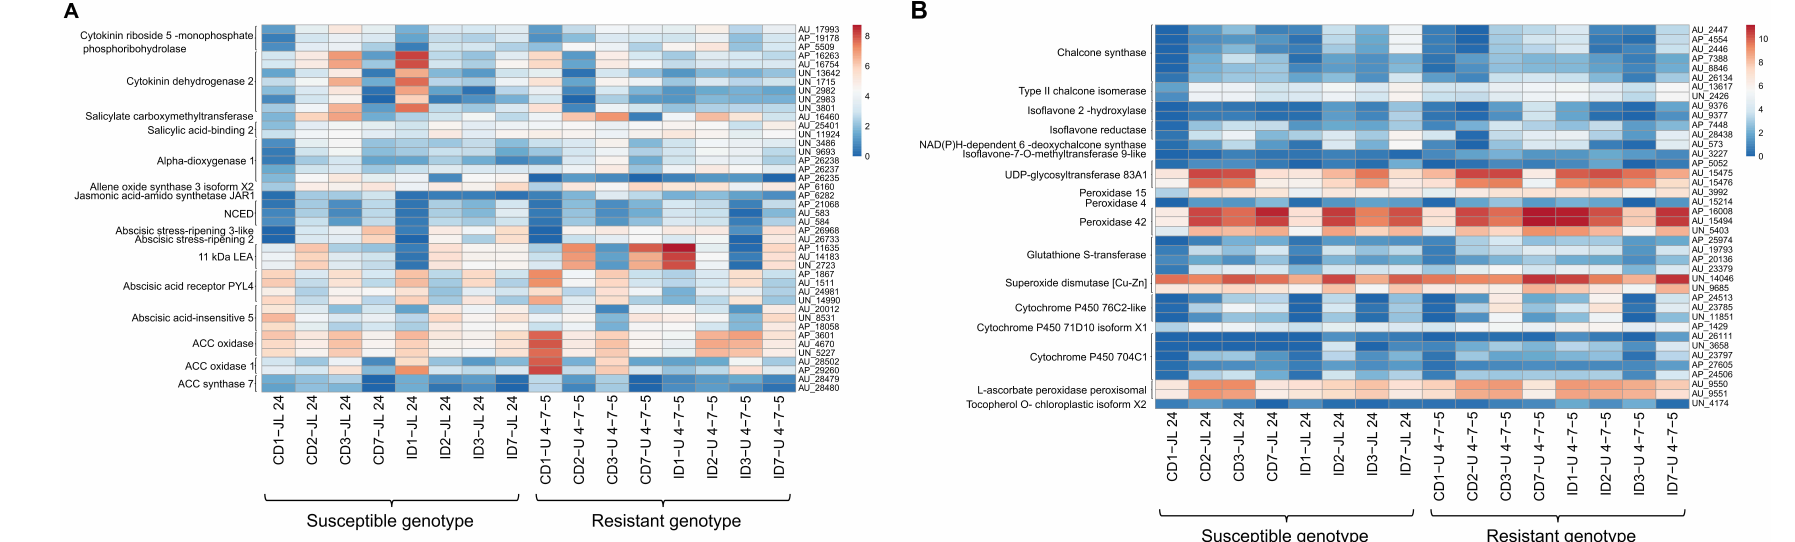
Figure 6. Di ff erentially expressed genes related to hormone biosynthetic, flavonoid biosynthesis and ROS detoxifying pathways. Heat maps of ( A ) hormone biosynthetic signaling related pathways transcripts a ff ected in 16 groundnut genotypes during control and infected conditions in response to infection with A. flavus . The red color depicts the upregulation and blue color depicts the downregulation in the gene expression pattern. The color code corresponds to the FPKM value of the transcripts which are increasing from blue to red color. Genotypes (JL 24 and U 4-7-5) and treatment level (control and infected) are shown at the top of the figure. Heat maps of ( B ) flavonoid biosynthesis and ROS detoxifying genes transcripts a ff ected in 16 groundnut genotypes during control and infected conditions in response to infection with A. flavus